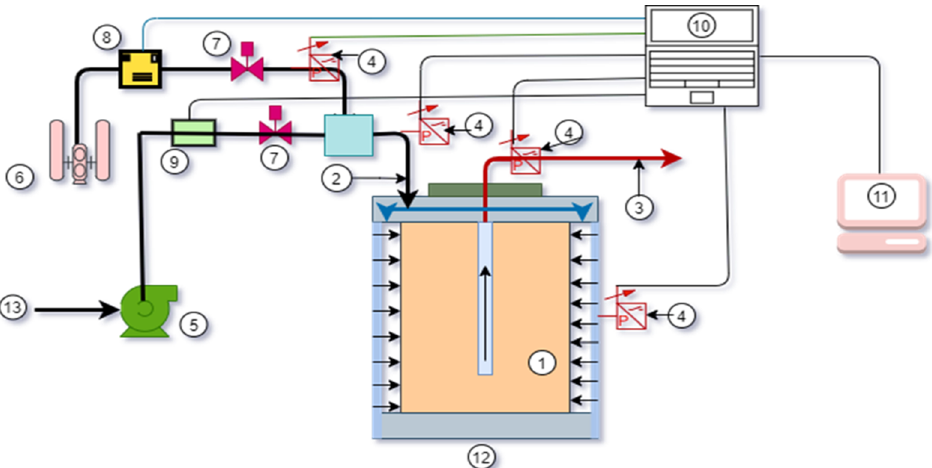
Figure 2. Schematic diagram of the experiment RFC facility: 1. Sample, 2. Inlet, 3. Outlet, 4. Pressure Sensors, 5. Water pump, 6. Air compressor, 7. non-Return valves, 8. Airflow meter, 9. Water flow- meter, 10. Data Acquisition, 11. Computer, 12. Samples Chamber, 13. Waterline.